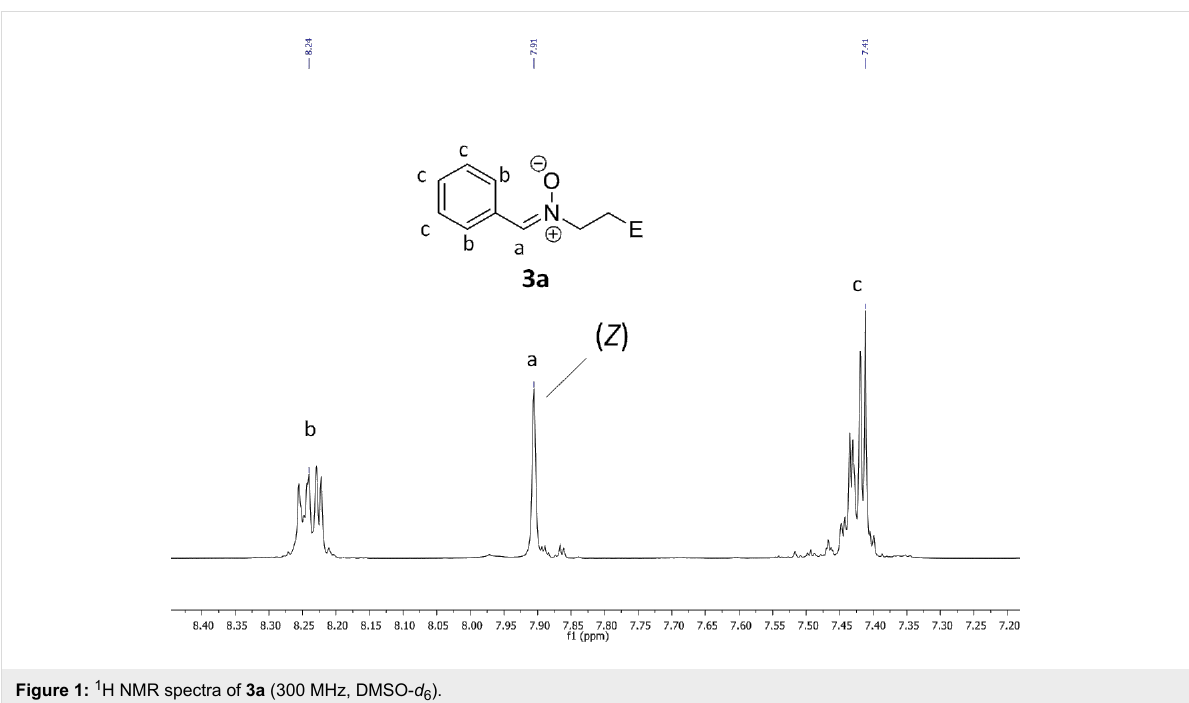
Figure 1: 1 H NMR spectra of 3a (300 MHz, DMSO- d 6